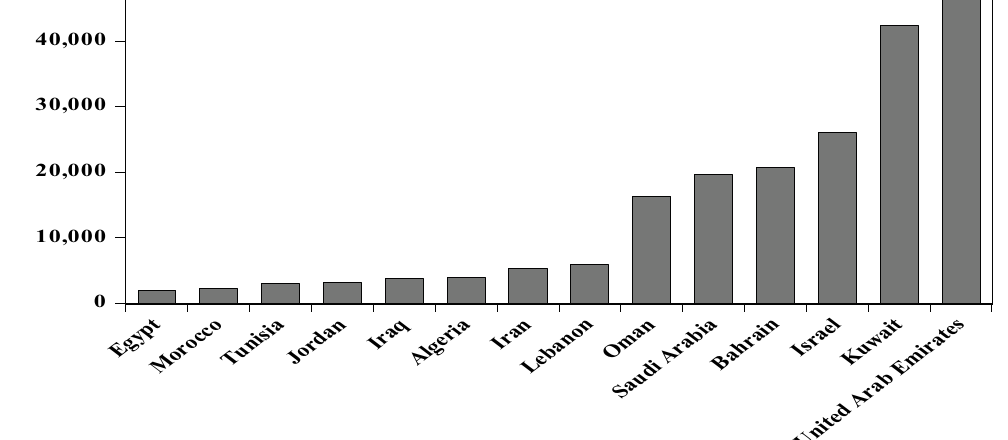
Fig. 4 Real GDP per capita in selected MENA countries (USD)